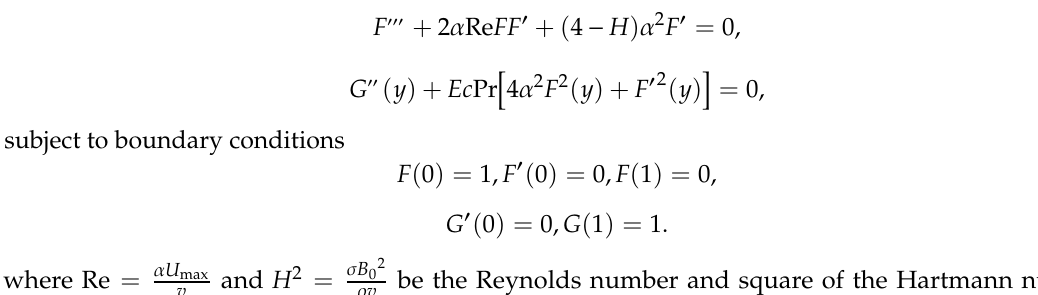
Figure 3. Variation of G(y) in diverging channel for Pr = 1, 2, 3, 4 and